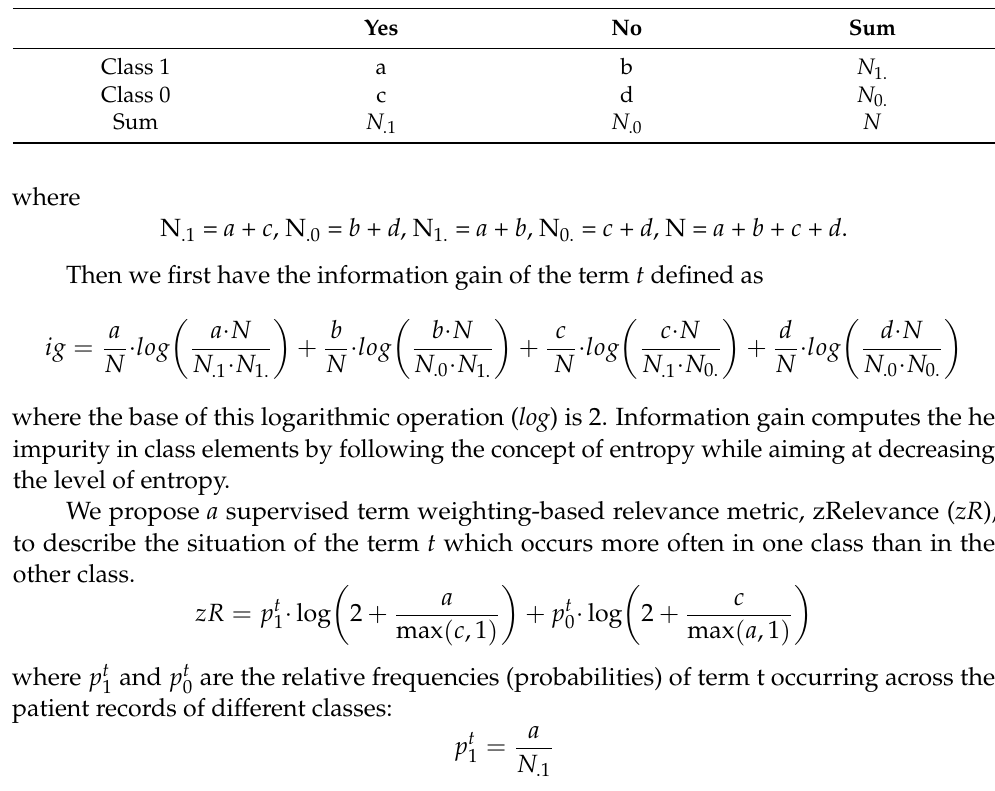
Table A1. Contingence table of term t across the two classes of patients. Term t Yes No Sum Class